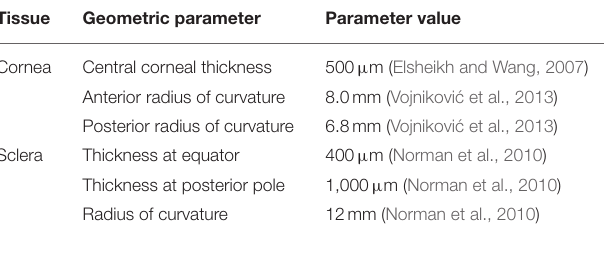
TABLE 1 | Summary of geometric parameters for finite element